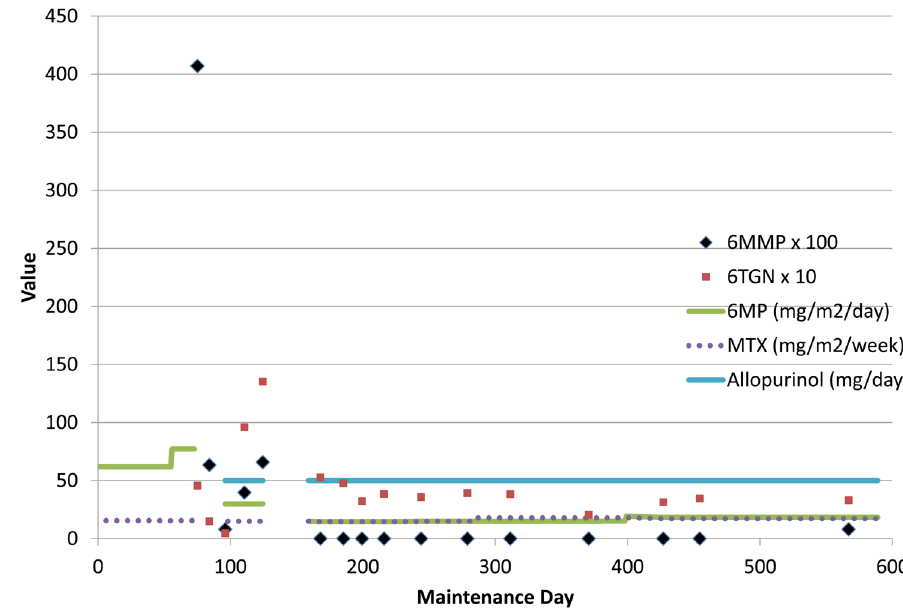
Figure 1. Treatment regimen for patient in Case 1. On the horizontal axis is the day of maintenance therapy from the start to completion. On the vertical axis are the red cell thiopurine metabolite values and drug doses. Interruption in drug doses is noted by a break in the line. For graph clarity, 6-methyl-mercaptopurine (6MMP) values were divided by 100 and 6-thioguanine nucleotide (6TGN) values by 10. After introduction of allopurinol, the 6MMP levels rapidly fell to undetectable levels with stable 6TGN. Following the initial introduction of allopurinol in patient 1 the mercaptopurine (6MP) and methotrexate (MTX) doses required interruption due to neutropenia which did not recur with a dose reduction of 6MP. As expected the myelosuppression was associated with a very elevated 6TGN